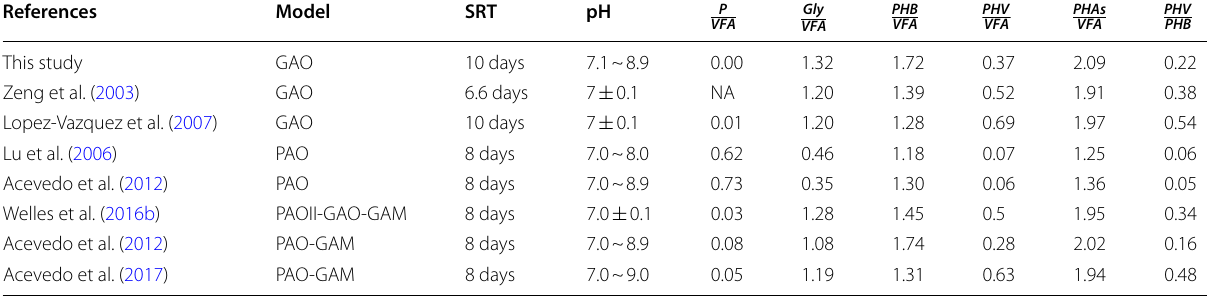
Table 1 Comparison of GAO and PAO models on ratios of PHB/PHV production, glycogen consumption, phosphorous release and acetic acid